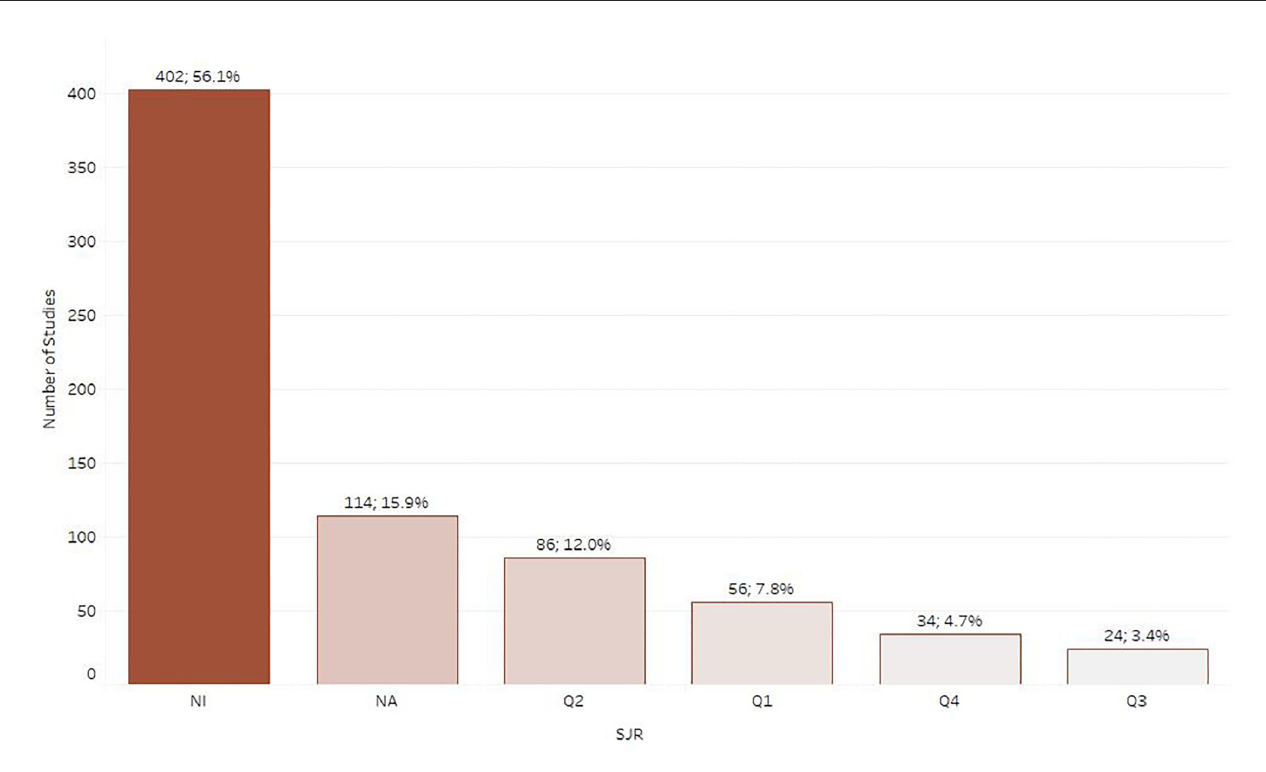
FIGURE2 Number of retrieved studies categorized by SCImago journal ranking system (SJR).